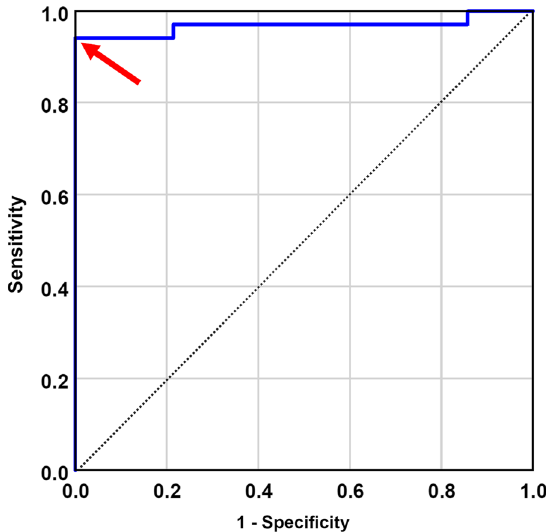
Fig. 5 Blue ROC curve for the test group’s putaminal z-scores of the CZT NDB to classify neurodegenerative vs. non-neurodegenerative PS (reference: visual rating). The dotted line serves as reference line. The optimal putaminal z-score cut-off for the CZT NDB ( index J 0.94) is marked with a red =